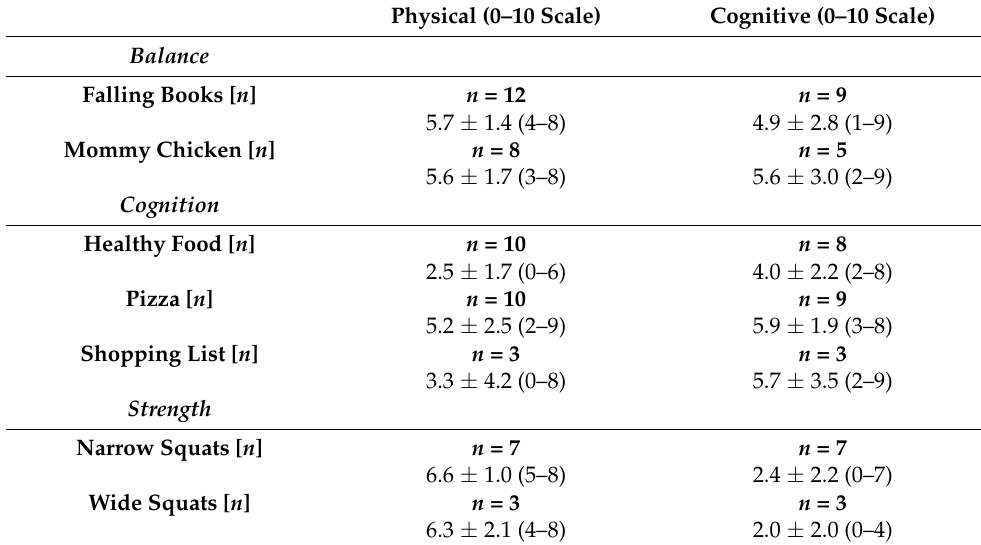
Table 3. Physical and cognitive intensity of the VITAAL